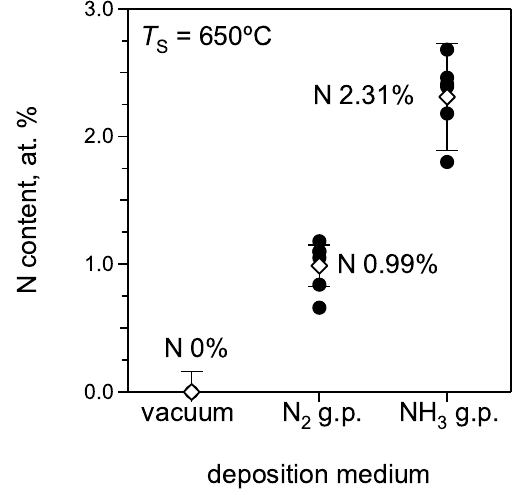
Figure 4. Average nitrogen content of films prepared in vacuum, with the ammonia and the nitrogen gas pulse. The open symbols are the calculated mean values and the error bars show the respective confidence intervals for the different deposition runs.